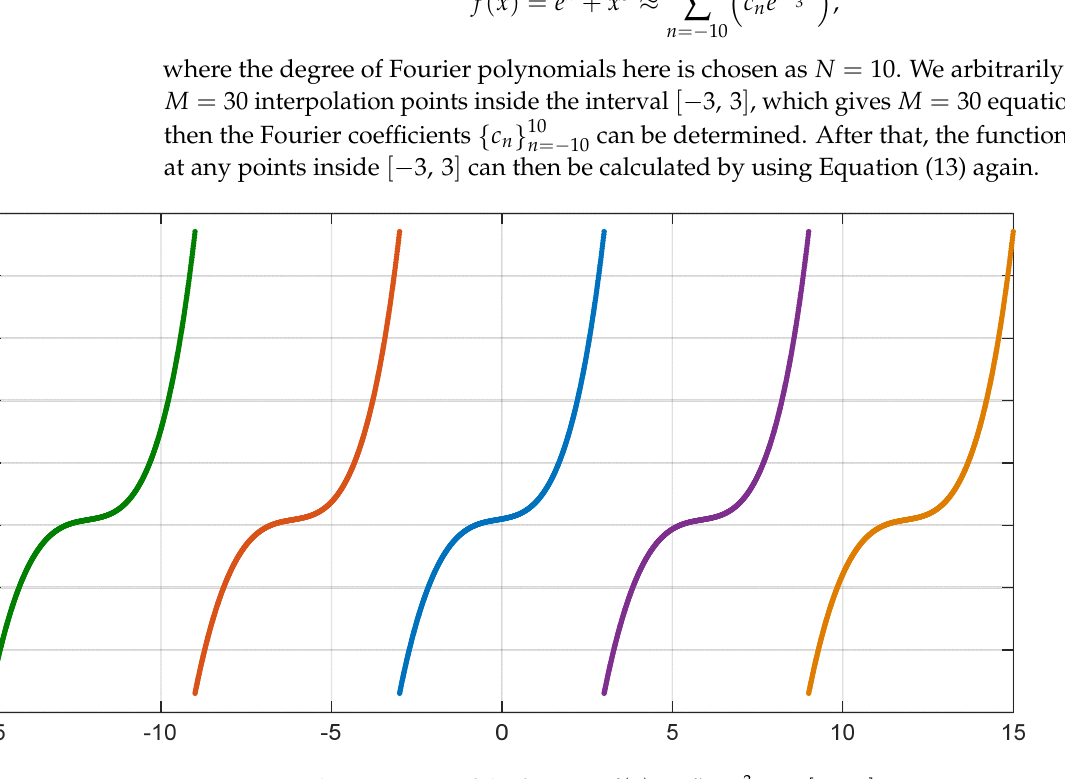
Figure 1. Periodic extensions of the function f ( x ) = e x + x 3 , x ∈ [ − 3, 3 ]